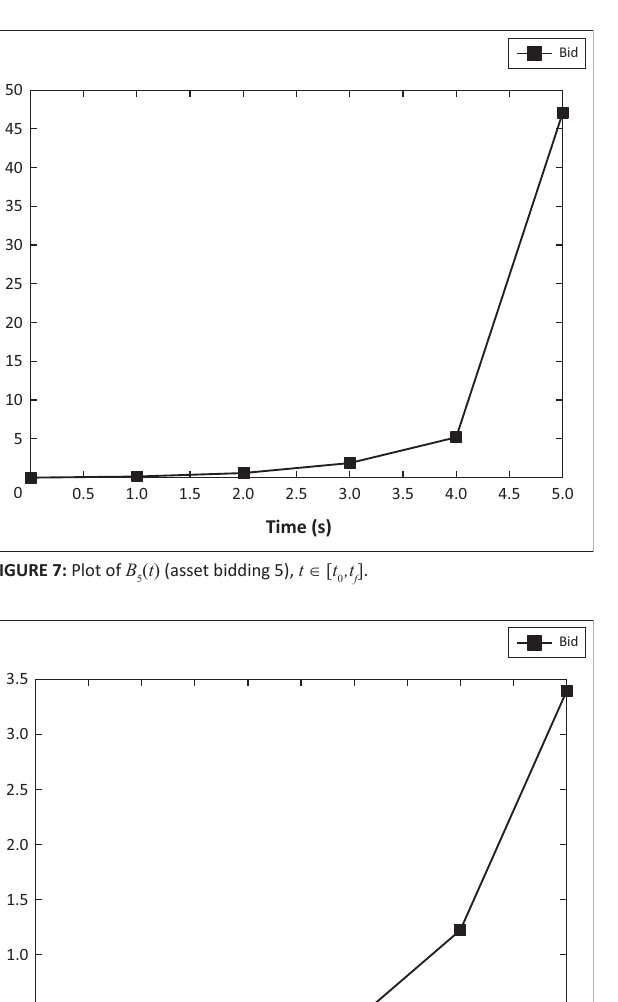
( t ) (asset bidding 6), t ∈ [ t 6